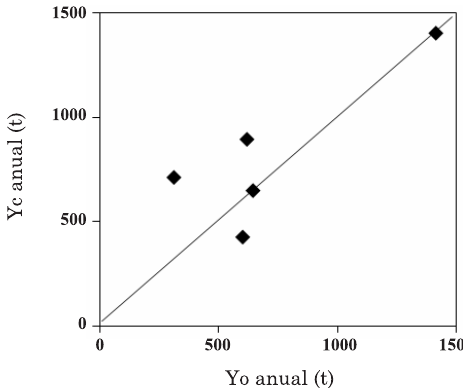
validação.Figura 7. Valores de aporte de sedimento anual observados e calculados pela MUSLE modificada na bacia do ribeirão Pipiripau, no período de